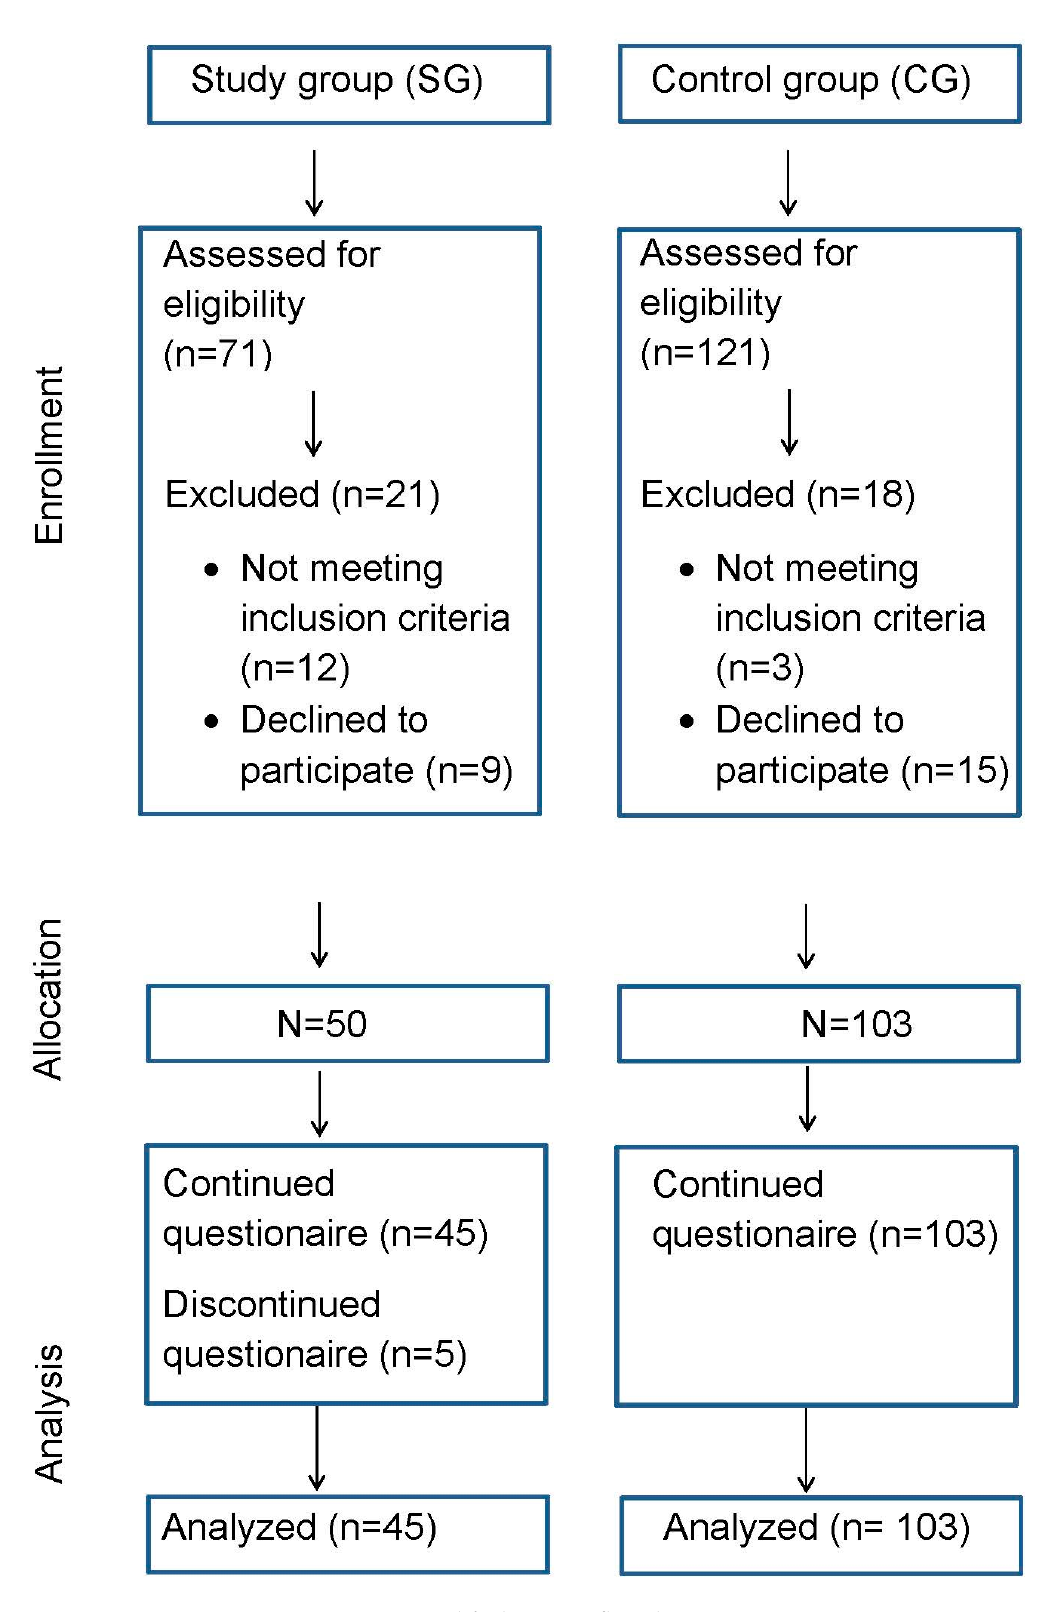
Figure 1. Modified Consort flow diagram.